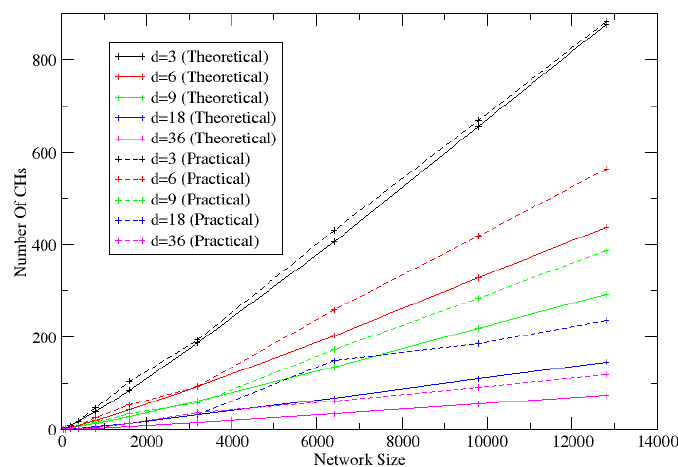
Figure 13. Theoretical and Practical number of elected CHs.